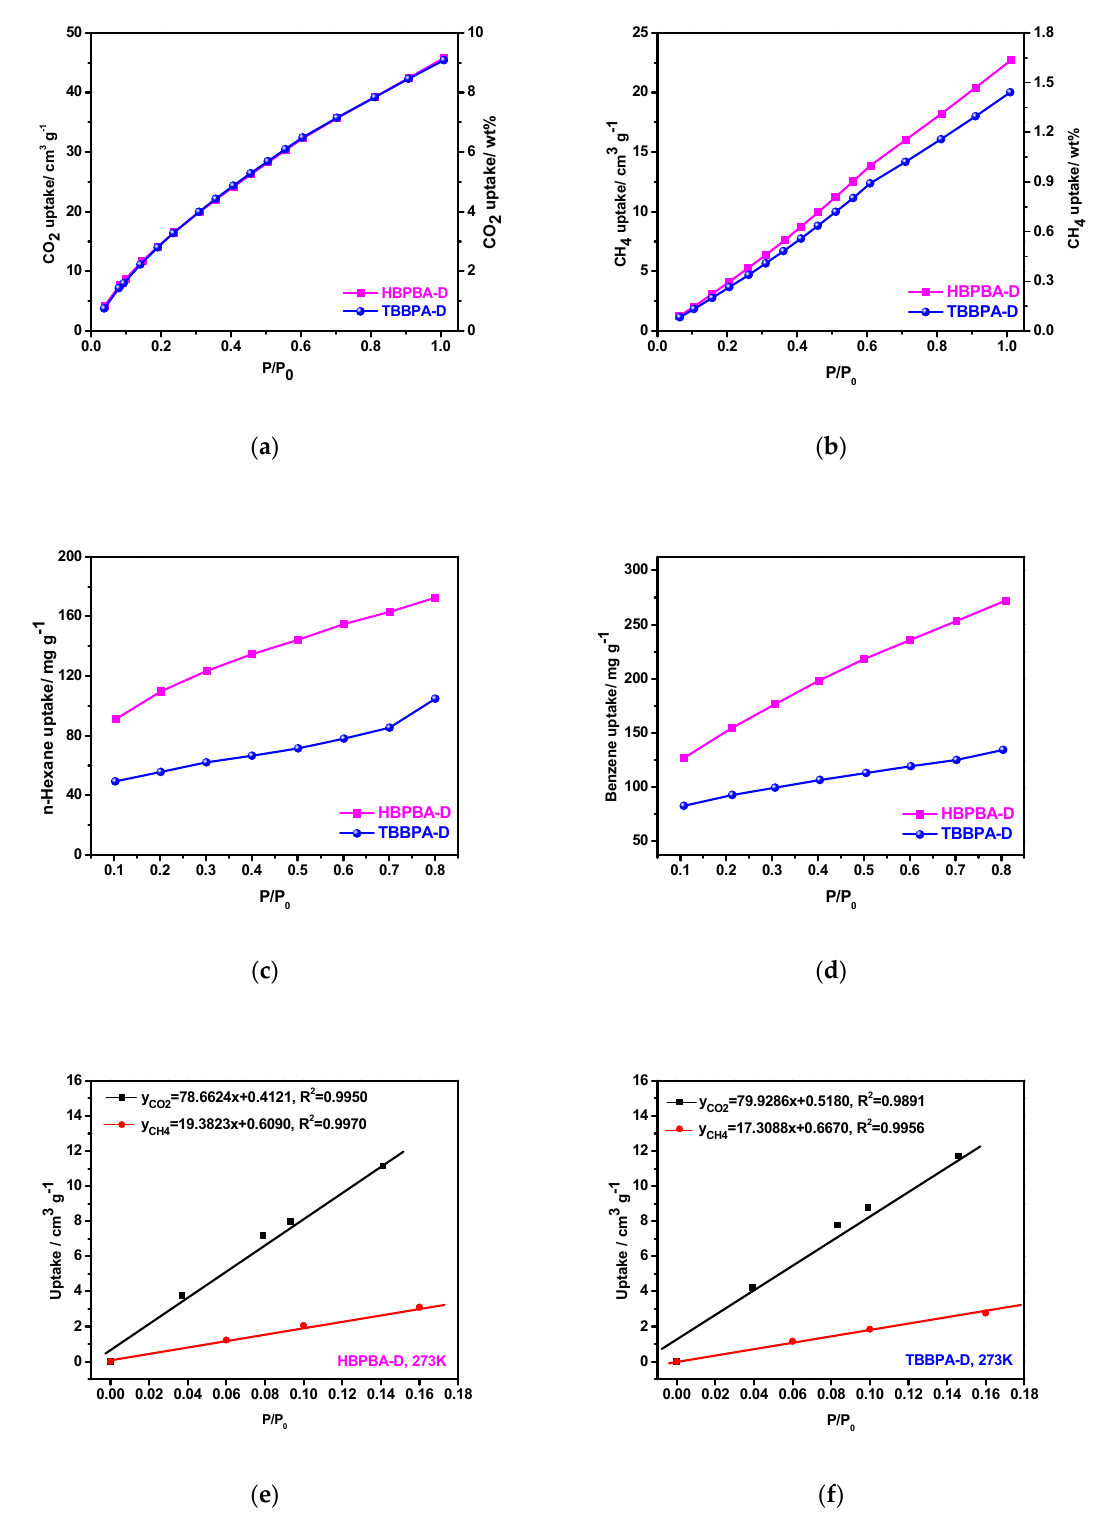
Figure 4. Adsorption isotherms of ( a ) CO 2 at 273 K/1 bar, ( b ) CH 4 at 273 K/1 bar ( c ) n-hexane, and ( d ) benzene at 298 K/0.8 bar; Selectivity calculation of CO 2 /CH 4 for the ( e ) HBPBA-D and ( f ) TBBPA-D according to the Henry’s law at 273